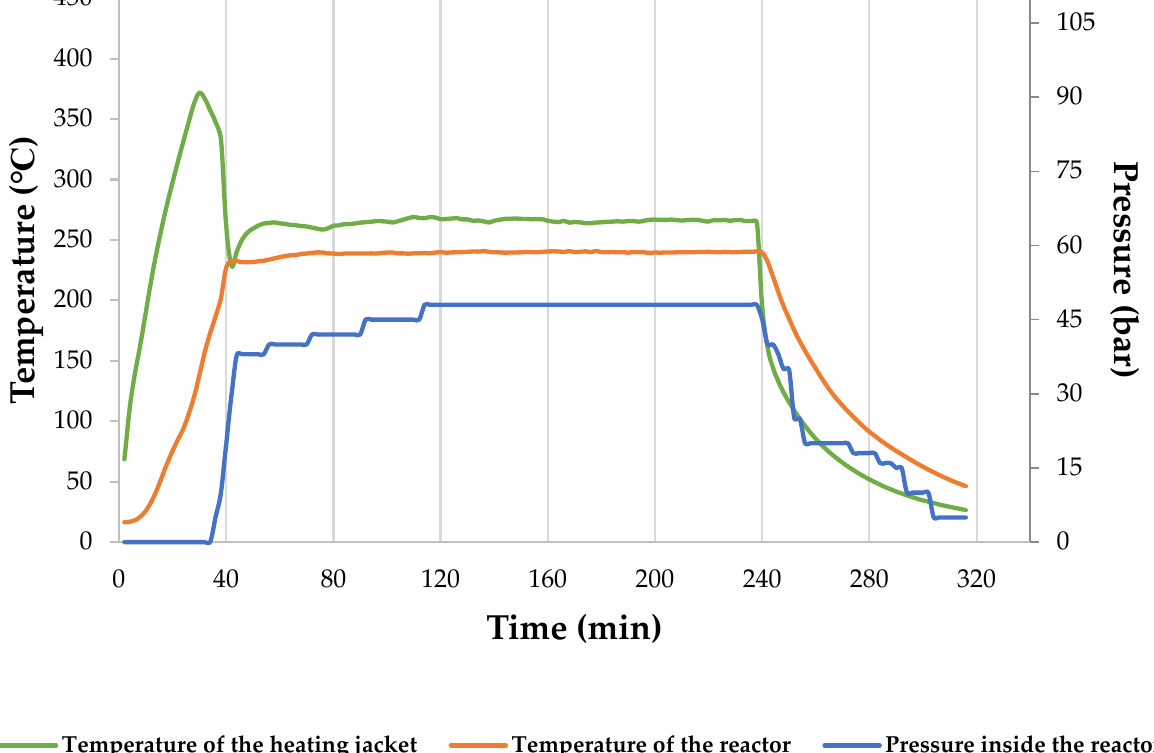
Figure A6. Temperature and pressure patterns during the process at 240 ◦ C in 180 min.